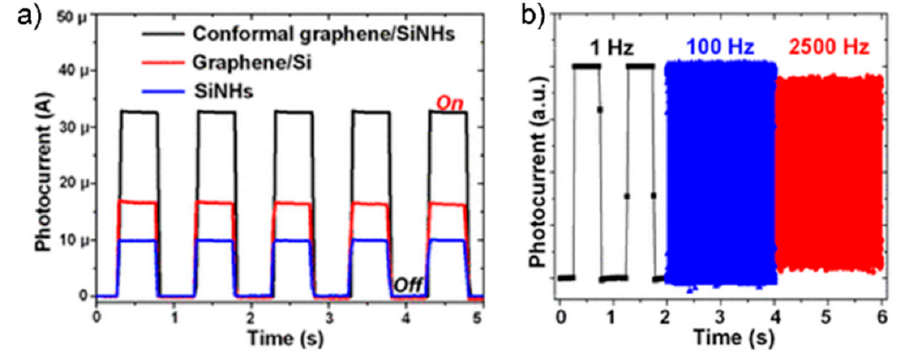
Figure 9. ( a ) Photoresponse of the graphene/Si, SiNHs, and conformal graphene/SiNH photode- tectors; ( b ) Photoresponse of the proposed photodetectors at 1, 100, and 2500 Hz of frequencies. ( a ), ( b ) Reproduced with permission from [108]. Copyright American Chemical Society,